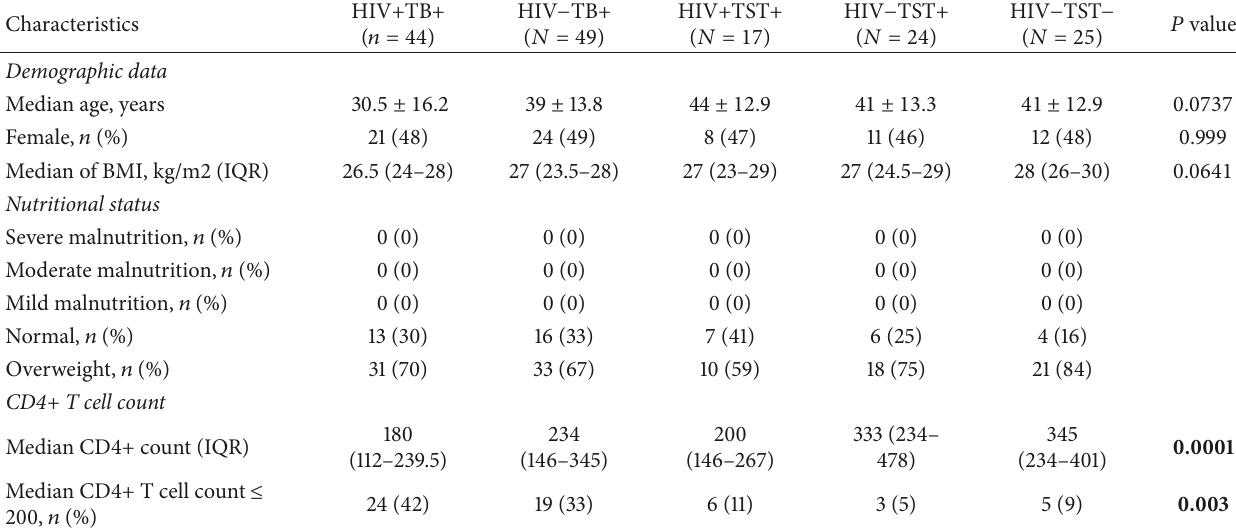
Table 1: Baseline study population